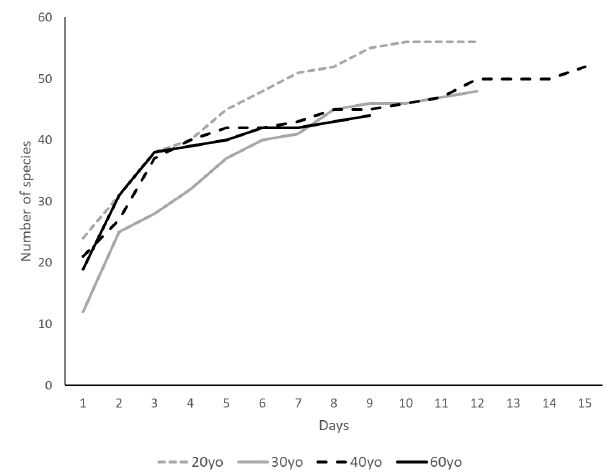
Figure 4. Bird species accumulation curves for the forest age classes. Table 3. Generalized linear mixed models (Poisson error family) ranked according to the lowest AICc value explaining variation in bird species richness by forest structural characteristics.